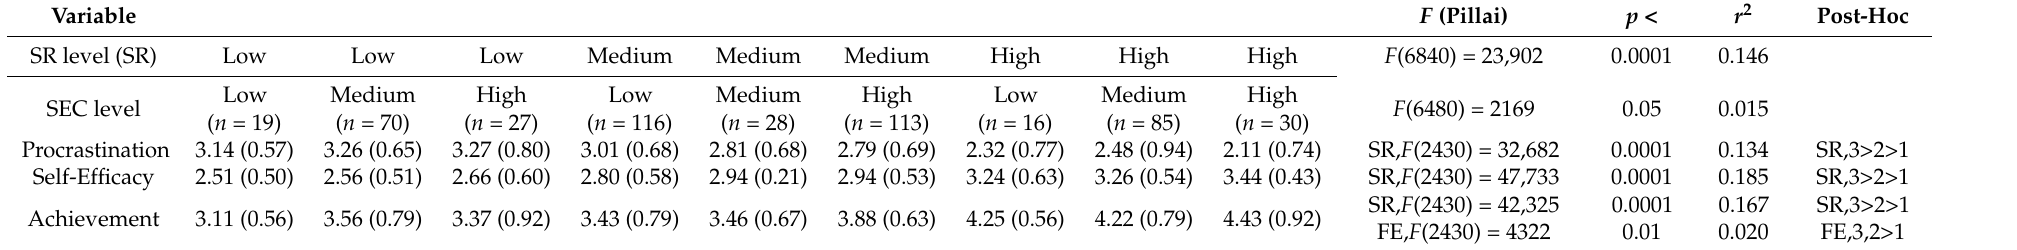
Table 5. Self-regulation (SR) and family education level (FE) effects on the adolescent’s academic